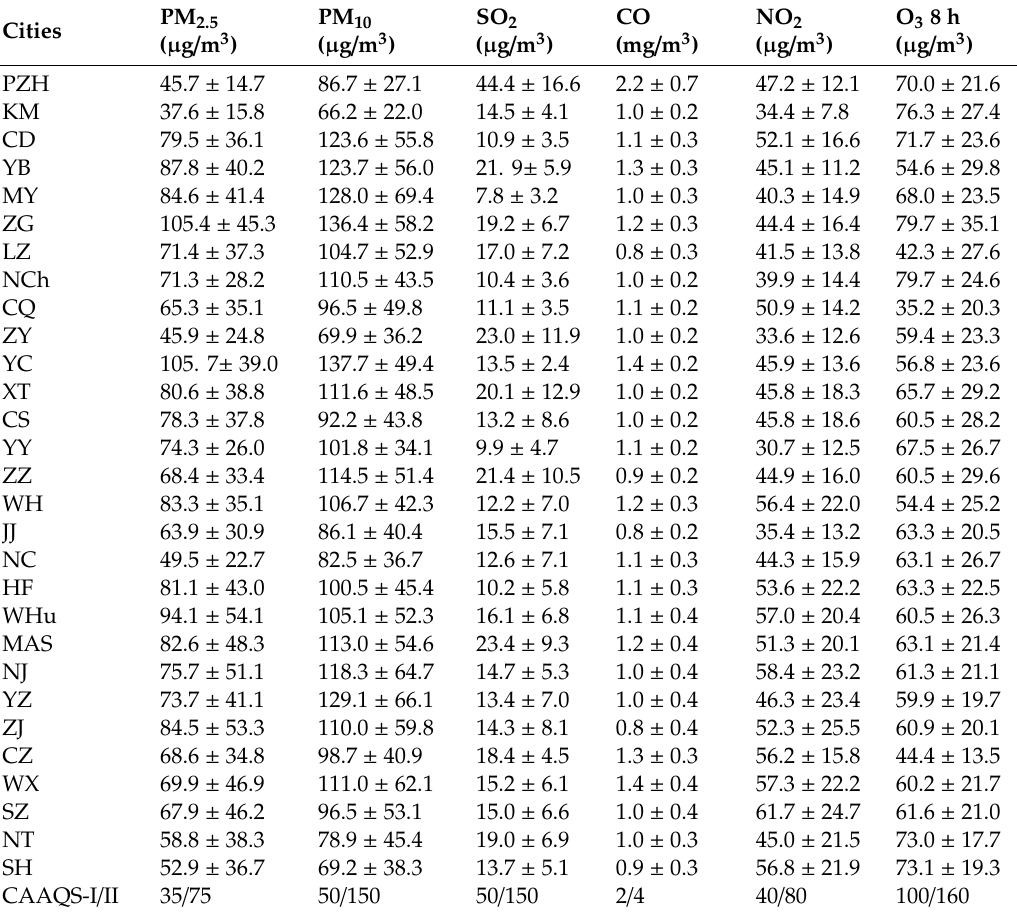
Table 2. Wintertime average concentrations and associated standard deviations of six criteria pollutants in all cities. PM: particle matter and CAAQS: Chinese Ambient Air Quality